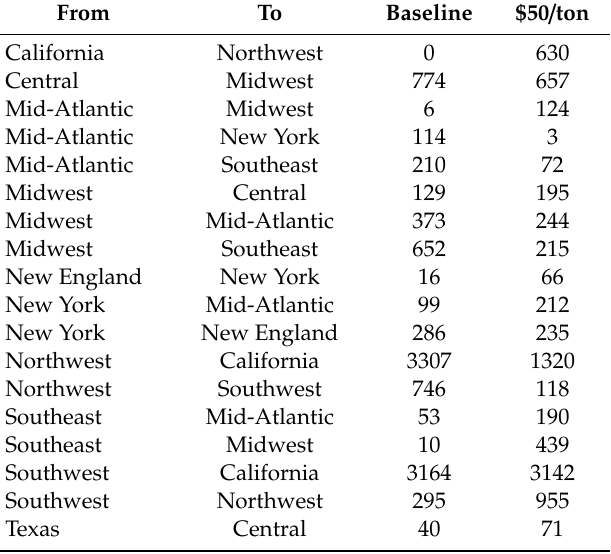
Table 6. Average electricity trade (MW) by market region, baseline and $50 / ton scenarios. Region pairs with less than 50 MW average trade are omitted. From